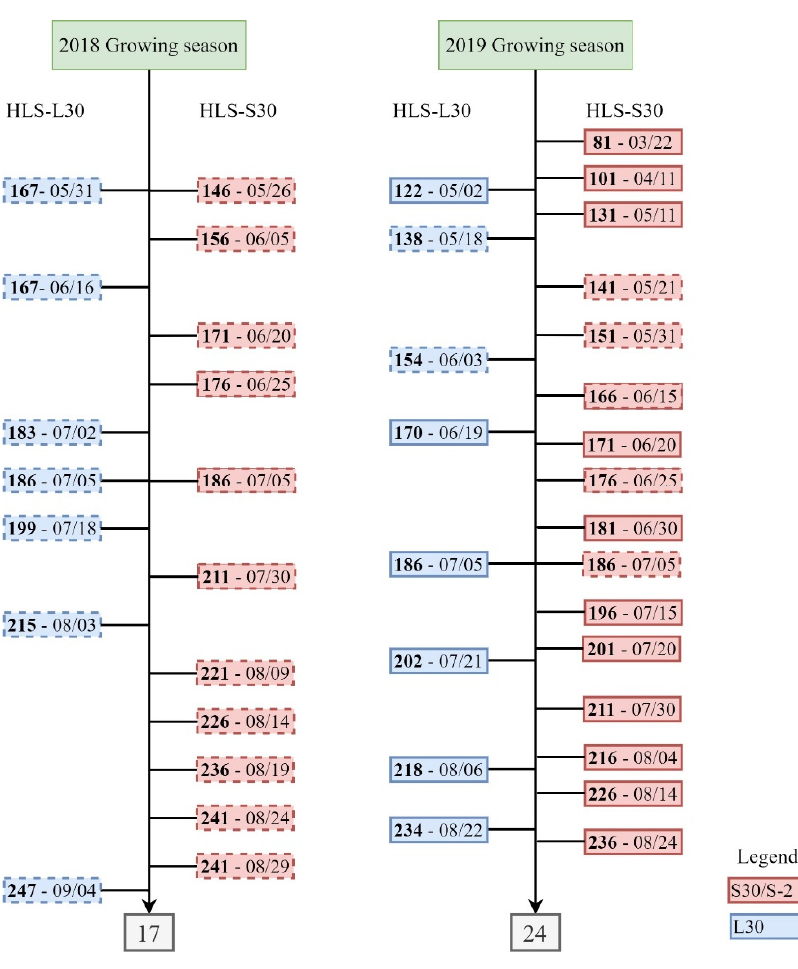
Figure 5. Harmonized Landsat-8 and Sentinel-2 (HLS) scenes used in the study, showing the day of year (DOY) (in bold) with the respective date of HLS products (Landsat 8 (L30) images blue boxes, Sentinel-2 (S30) red boxes), with the respective number of total images in grey boxes. S2 images from THEIA were also obtained on the S2 dates (red boxes). Dashed boxes represent the HLS scenes used to validate LAI, whereas full boxes indicate scenes used to generate crop biophysical variable time-series during the 2019 growing season.